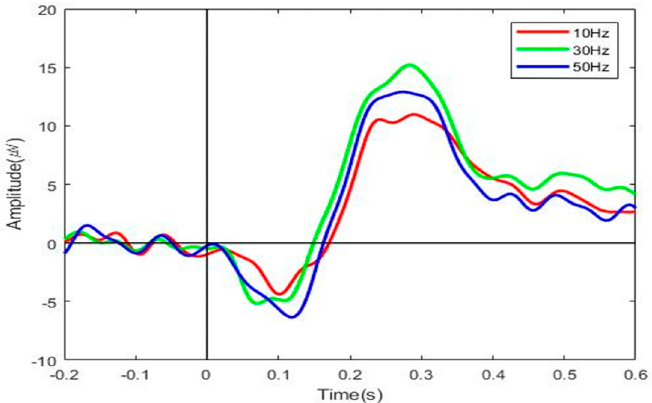
Figure 7. Average ERP signal measured in the C3 somatosensory area for magnetic field stimulation with three frequencies.